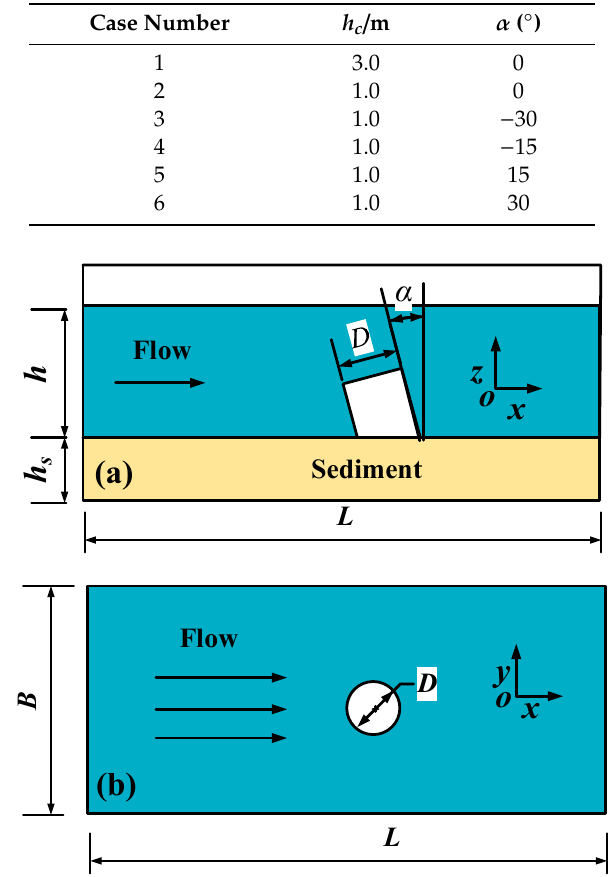
Figure 5. Sketch of the computational domain, ( a ) side view; ( b ) top view.